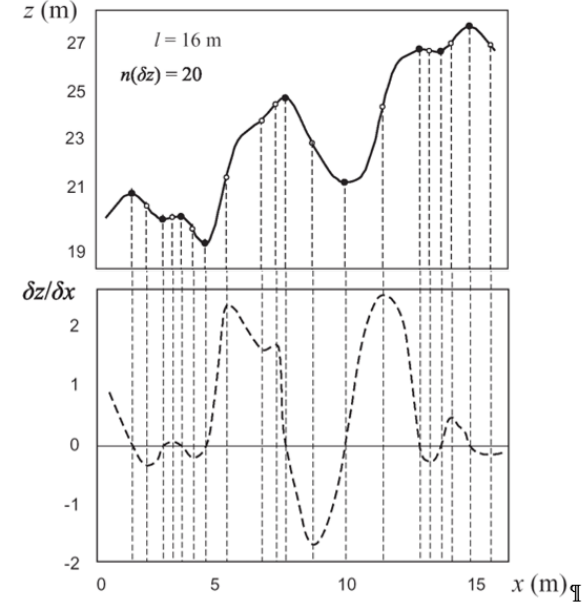
Figure 6. Terrain analysis concept for the selection of suitable grid size, depicting the variation of elevation ( z ), the slope (first derivative) of the terrain p δ z { δ x q and the number of inflection n p δ z q points over a given length l .